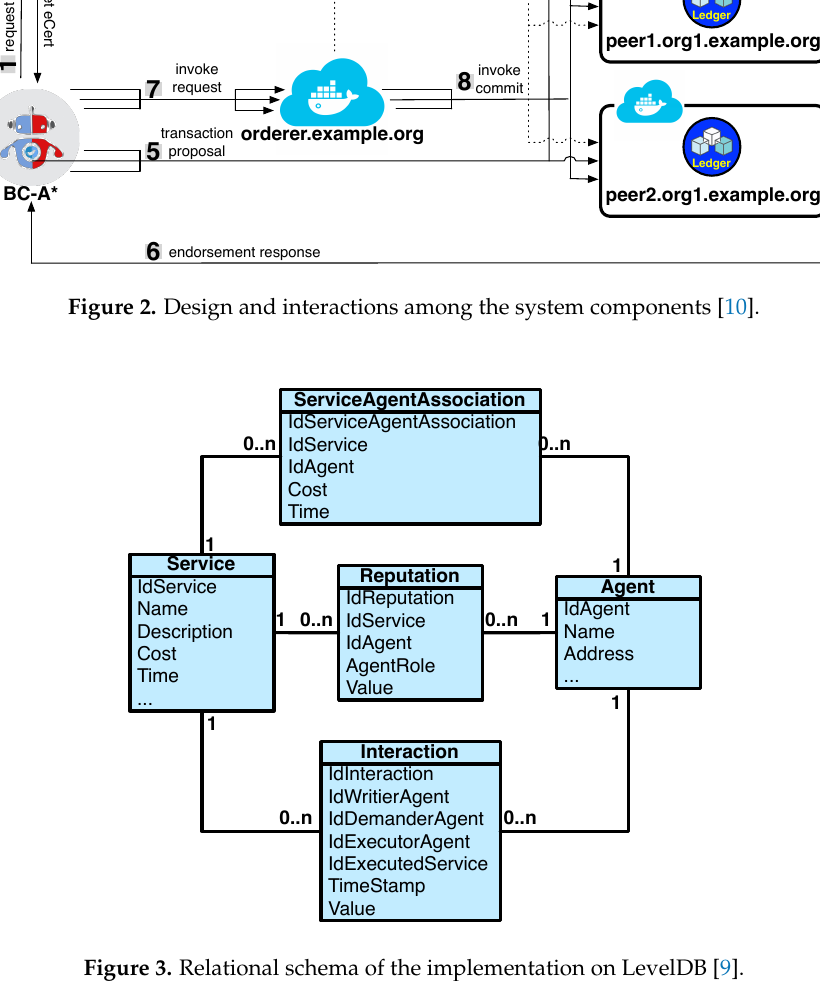
Figure 3. Relational schema of the implementation on LevelDB